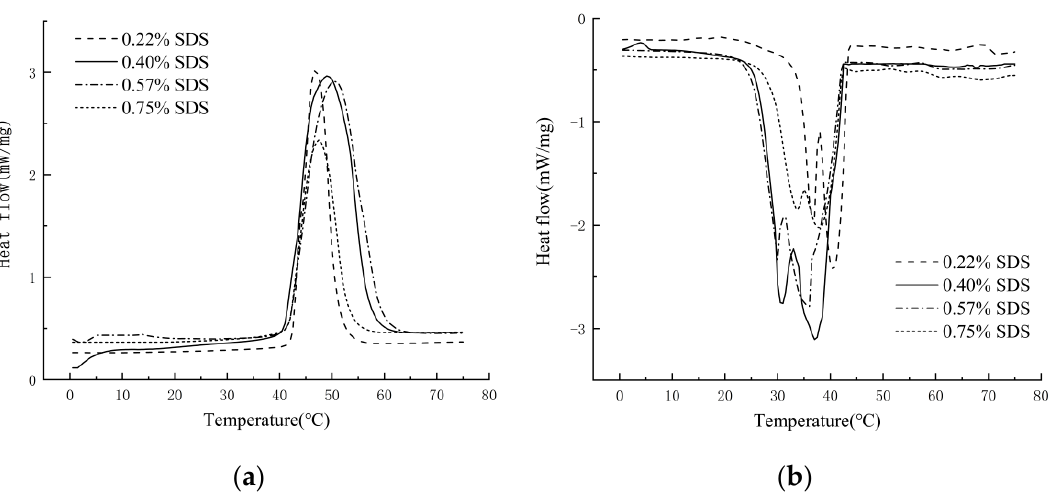
Figure 8. DSC curves of MPCMs with different mass fractions of SDS emulsifier with an ultrasonic oscillation time of 10 min, pH of 4.5, core–shell ratio of 1:1. ( a ) Melting and ( b ) crystallization processes at a temperature rate of 10 K/min in a 60 L/min flow of N 2 . Table 8. Experimental results for changing the mass fraction of emulsifier.